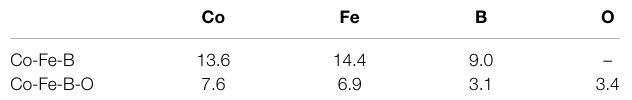
TABLE 1 | Average coordination number of the elements.